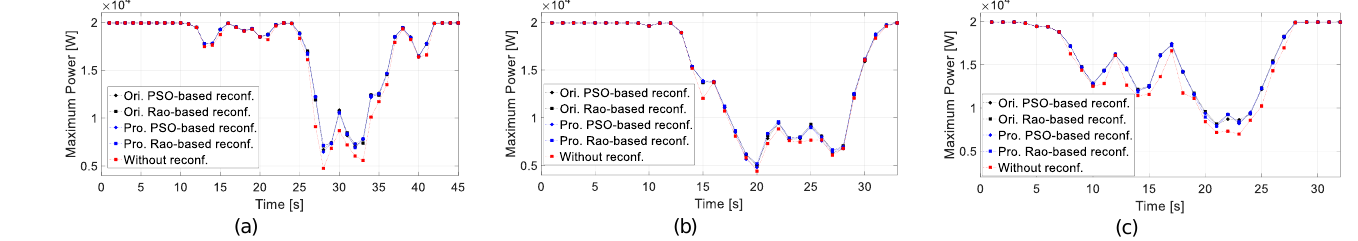
Figure 21. Comparison of maximum output power profiles of TCT-configured, original-PSO-reconfigured, original-Rao-reconfigured, proposed-PSO-reconfigured, and proposed-Rao-reconfigured PV arrays under three shading cases without lagged time. ( a ) Case 1. ( b ) Case 2. ( c ) Case 3. The performance metrics of the PV array are presented in Table 3. In Case 1 and